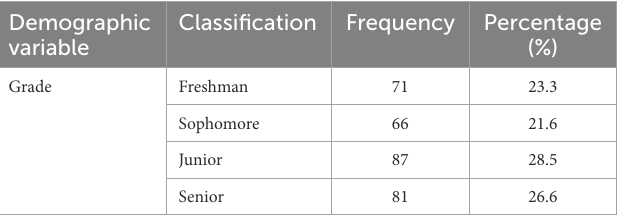
TABLE 1 Basic information of survey